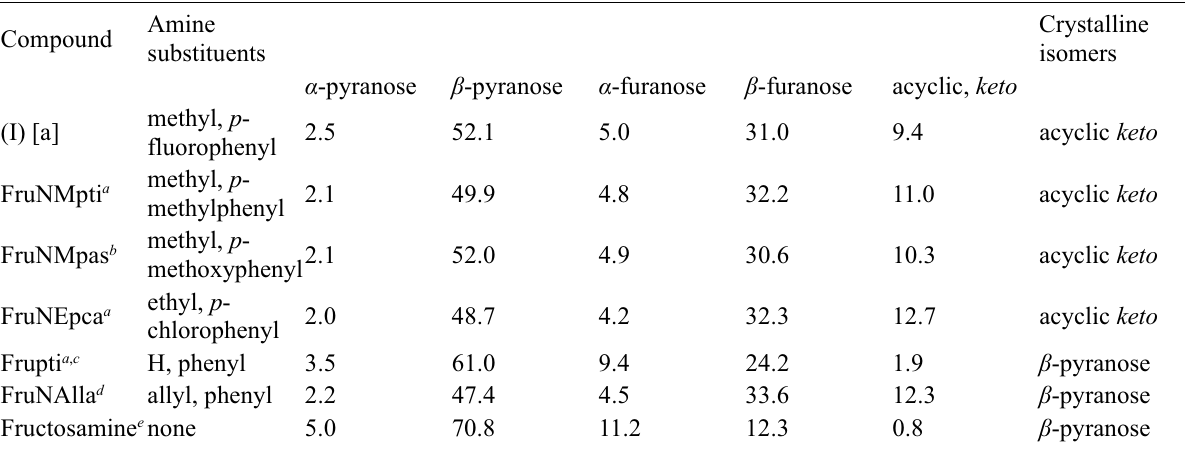
Supplementary Table 1S. Distribution (%) of cyclic and acyclic forms of some 1-amino-1-deoxy-D-fructose derivatives in D2O/pyridine (1:1) at 293 K, as estimated from the 13 C NMR spectra, and in the crystalline state